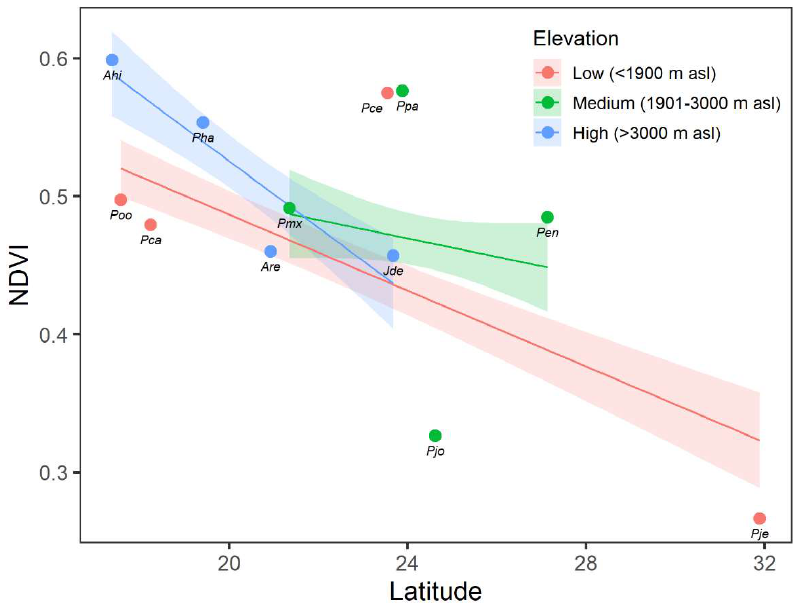
Figure 8. Linear relationship between the normalized difference vegetation index (NDVI) and latitude using data collected from different conifer species across the Mexican territory in the following elevation classes: low (<1900 m asl; red points and lines), intermediate (1901–3000 m asl; green points and lines), and high (>3000 m asl; blue points and lines). Points indicate the observed annual mean NDVI in each species for the period 2000–2020. Lines and shaded regions represent the predicted values and the 95% confidence band from the linear fit, respectively.